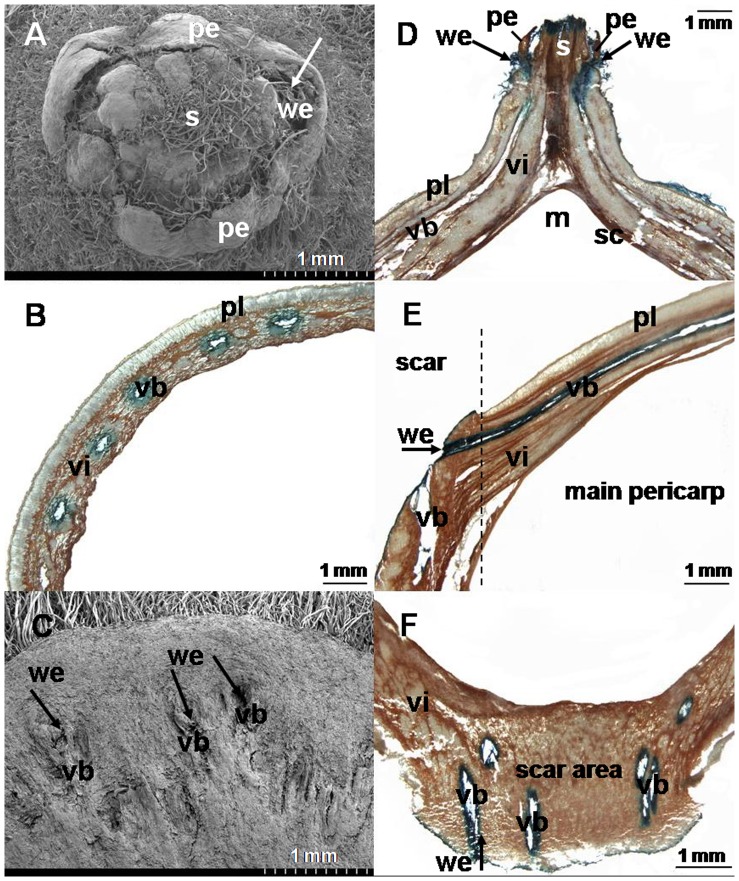
The routes of water flow into fresh Q. fleuryi fruits when imbibed in water.(A) SEM photograph of apical end of fruit; (B) cross-section of the main pericarp area of the fruit following imbibition in 5‰ Methylene Blue for 8 h, showing that vascular bundles in vascularised inner pericarp layer stained blue; (C) SEM photograph of the surface of the scar, showing the open ends of the vascular bundles of the pericarpial vascular system; (D) longitudinal section through the apex, with Methylene Blue staining showing that water entered into the fruit at the point where the remains of the perianth segments are attached; (E) longitudinal section of the scar (to the left of the dashed line) and the main pericarp (to the right of the dashed line), with Methylene Blue staining showing that water enters from the scar directly into the pericarpial vascular system that penetrates the inner pericarp layer; (F) longitudinal section of the scar with Methylene Blue staining only the vascular bundles whereas the surrounding water-impermeable sclerenchymatous tissue remains unstained; m = micropylar area of the fruit (embryo missing in photograph); pe = perianth remains; pl = palisade layer; s = stylar remains; sc = seed coat; vb = vascular bundle; vi = vascularised inner pericarp layer; we = point of water entry. Arrows show the points of water entry.